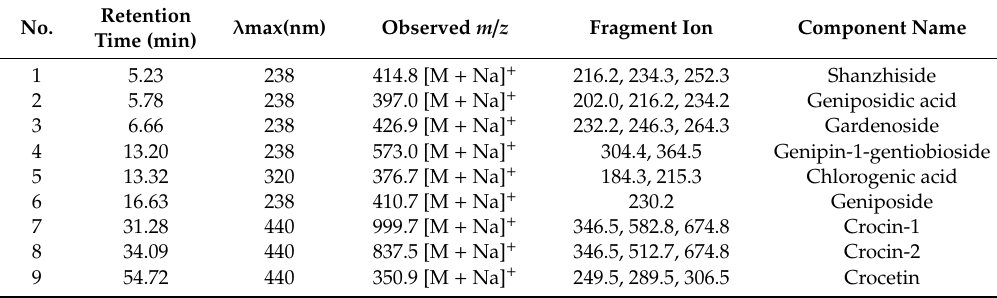
Figure 2. HPLC chromatograms. ( A ) Aqueous extract of Fructus Gardeniae . ( B ) Standard chemicals. Table 1. HPLC- ESI-MS data of nine common peeks.